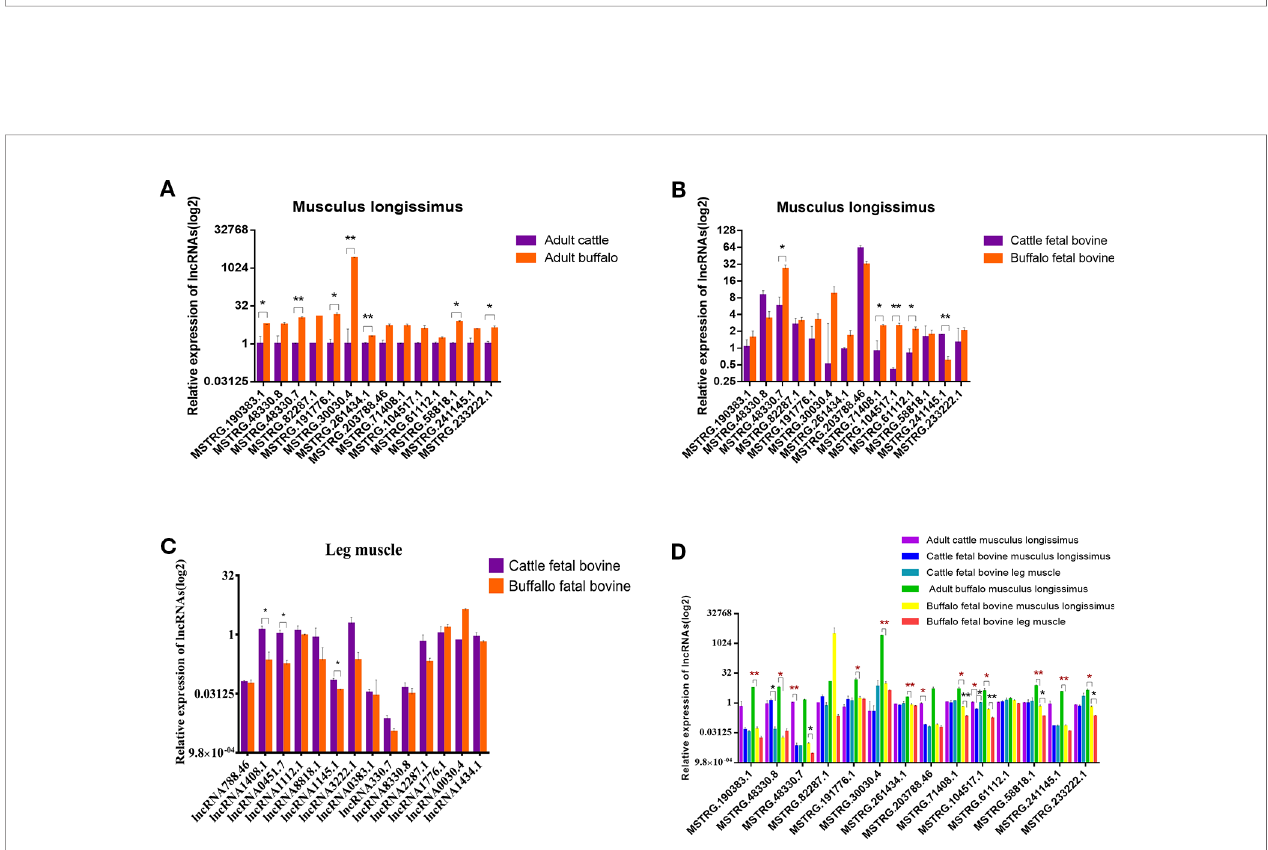
FIGURE 6 | Validation of putative lncRNA. (A) 14 lncRNAs were selected and identi fi ed, as they exhibited signi fi cantly different expression patterns (assessed from our RNA-sequencing approach) when comparing longissimus dorsi muscles, using quantitative real-time PCR (qRT-PCR). (B) 14 lncRNAs were identi fi ed in fetus cattle and buffalo longissimus dorsi muscles using qRT-PCR. (C) 14 lncRNAs were identi fi ed in fetus cattle and buffalo leg muscles using qRT-PCR. (D) The expression of 14 lncRNAs in cattle and buffalo muscle tissue. *P < 0.05, **P <